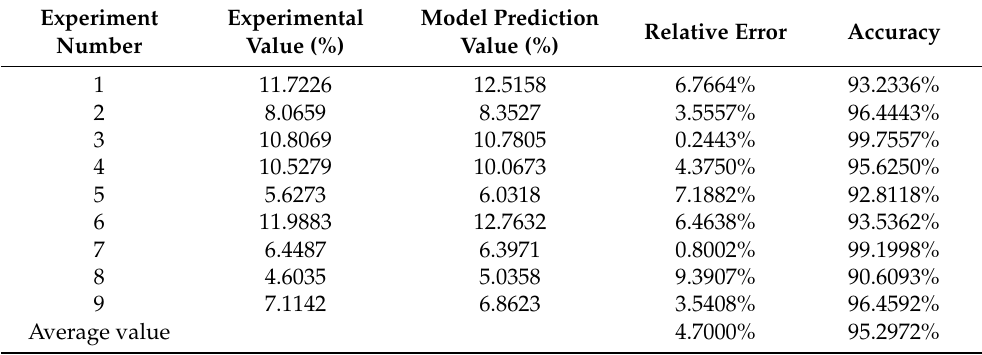
Figure 4. Comparison of energy conversion efficiency between experimental and predicted values. Table 6. Global model validation.